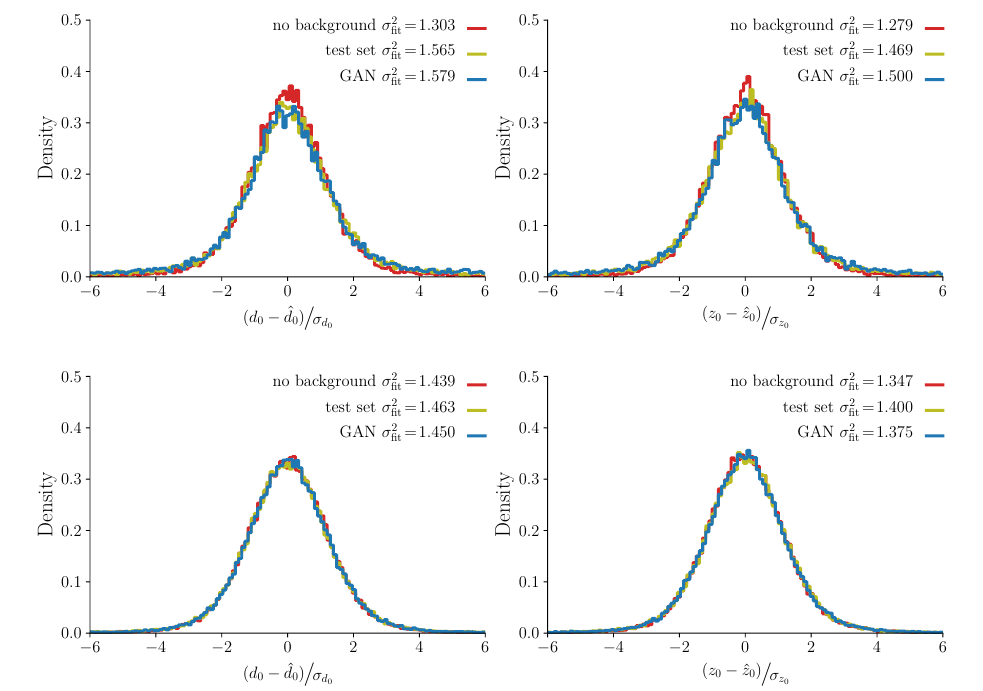
Figure 3: Comparison of pulls of impact parameter in the transverse plane (left) and in beam direction (right) for the transverse momentum ranges p T < 0 . 2 GeV (top) and 0 . 2 < p T < 1 GeV for the cases of (a) no background in the PXD, (b) fully simulated PXD background as in the input data (test set), and (c) PXD background generated with the GAN. The values in the top right are the widths of a Gaussian fitted to the pull distributions.